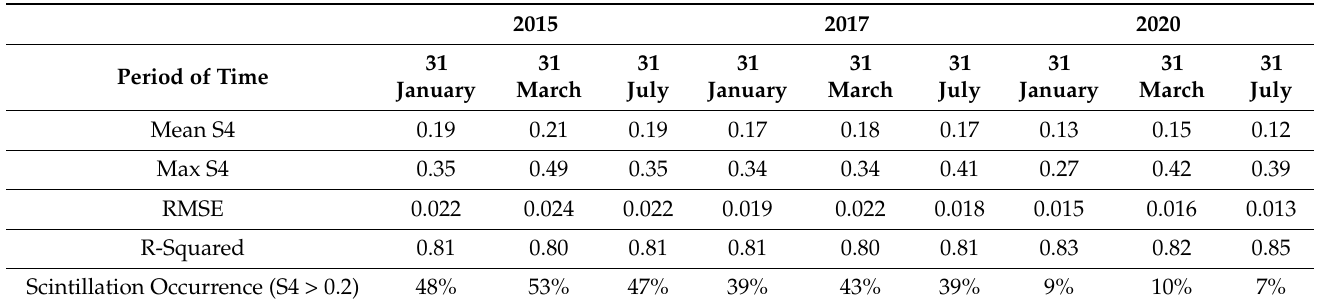
Figure 3. The predicted and observed S4 during 24 h on 31 January, 31 March, and 31 July in 2015, 2017, and 2020. Table 2. The difference between predicted and observed S4 values during 24 h on 31 January, 31 March, and 31 July in 2015, 2017, and